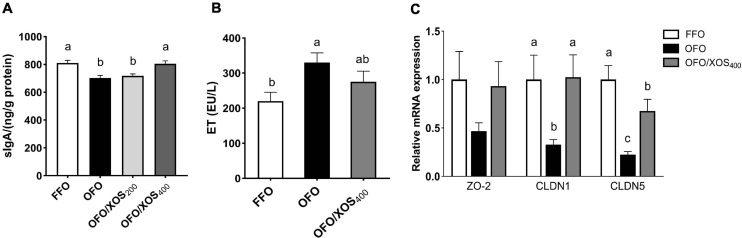
Effect of dietary xylooligosaccharide supplementation on ileal barrier of laying hens fed oxidized fish oil. (A,B) Show the secretory immunoglobulin A (sIgA) content of ileal mucosal and the endotoxin concentration in serum, respectively. (C) Shows the gene expressions of zona occludens-2 (ZO2), claudin-1 (CLDN1), and claudin-5 (CLDN5) in the ileal mucosa. Data are presented as the means ± SEM (n = 8). FFO, fresh fish oil diet; OFO, oxidized fish oil diet; OFO/XOS200, oxidized fish oil diet + 200 mg/kg of xylooligosaccharide; OFO/XOS400, oxidized fish oil diet + 400 mg/kg of xylooligosaccharide. Bars with no common letter indicate statistical differences among treatments (P < 0.05).